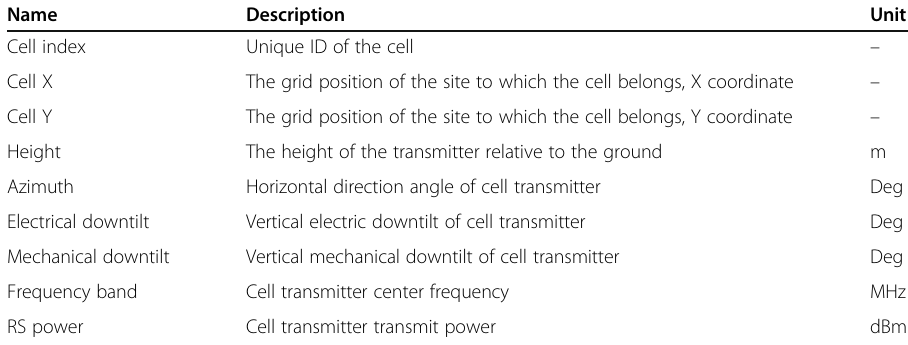
Table 1 Description of engineering parameter